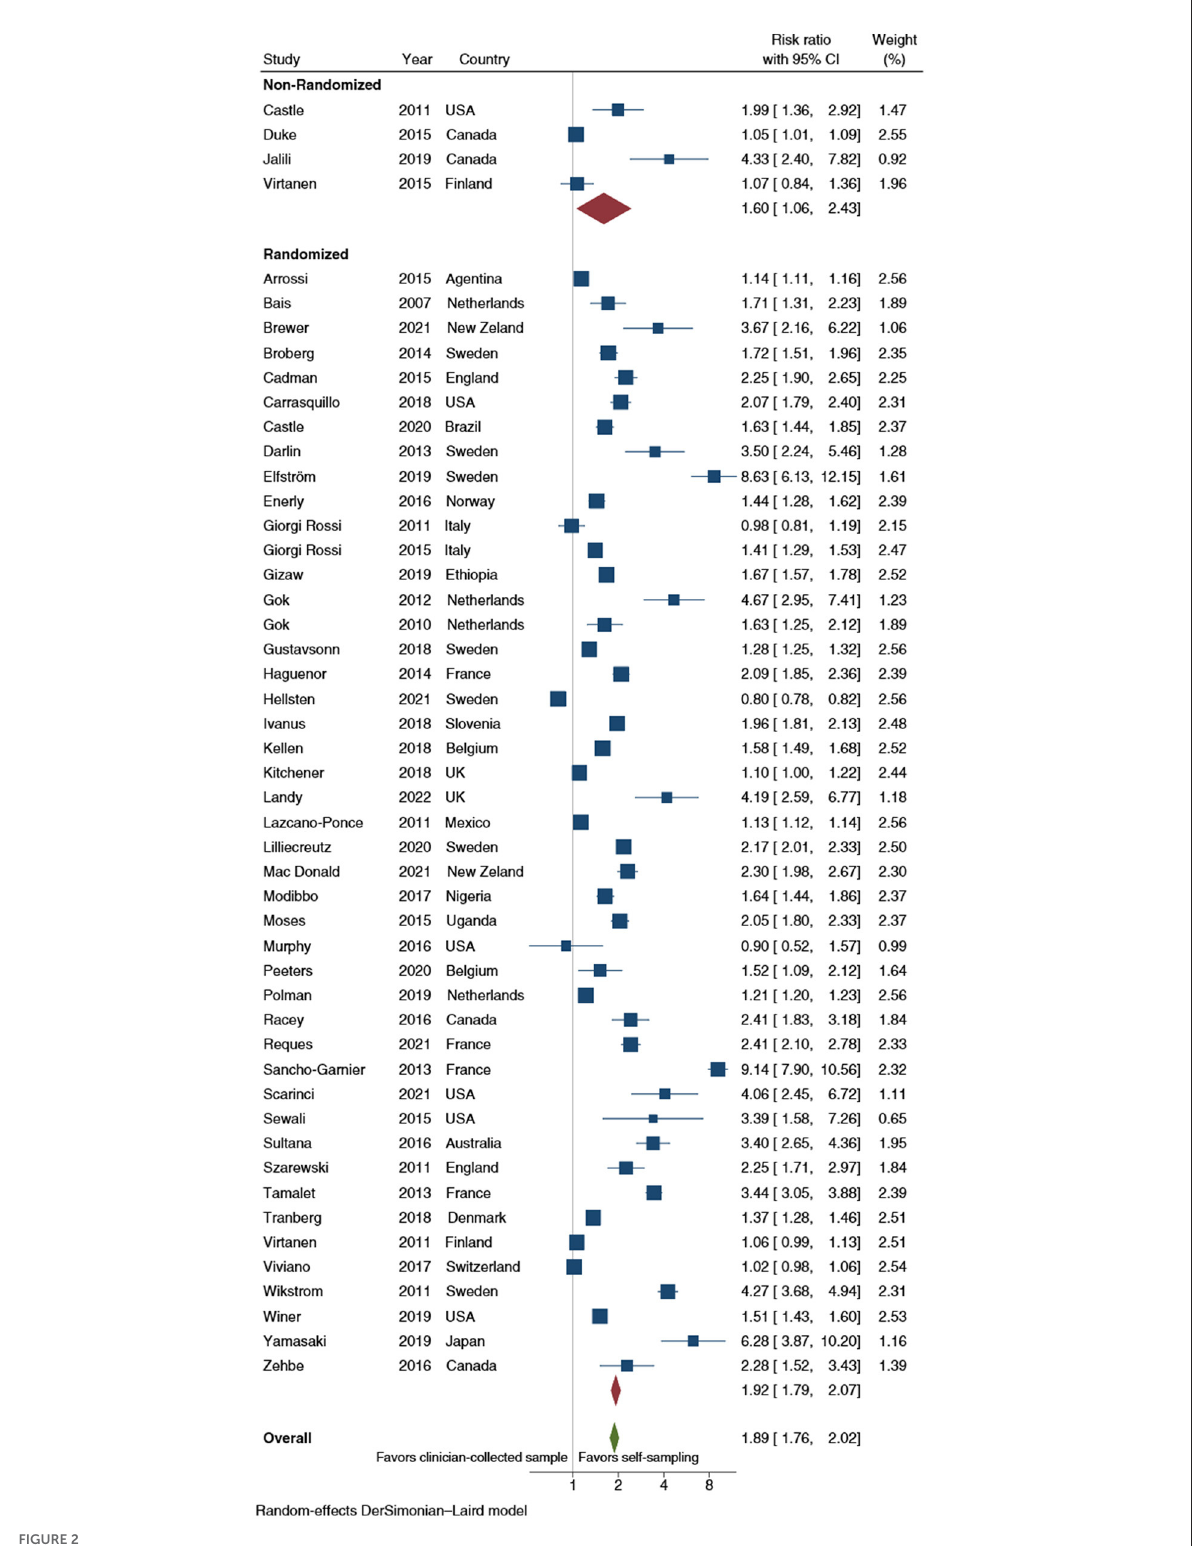
FIGURE2 Forest plot comparing cervical cancer screening (CCS) uptake for HPV testing by self-sampling vs. clinician-collected samples, subgrouped by study design (randomized vs. non-randomized). Homogeneity: I 2 = 98.9%; Cochrane’s Q test for between-group differences: Q = 4,241.88; df = 1; p =